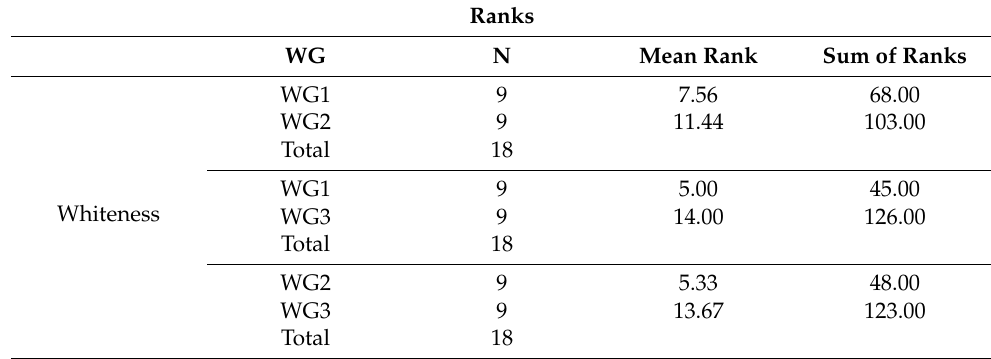
Table A6. Ranks table of Mann–Whitney U test for the whiteness, according to the WG